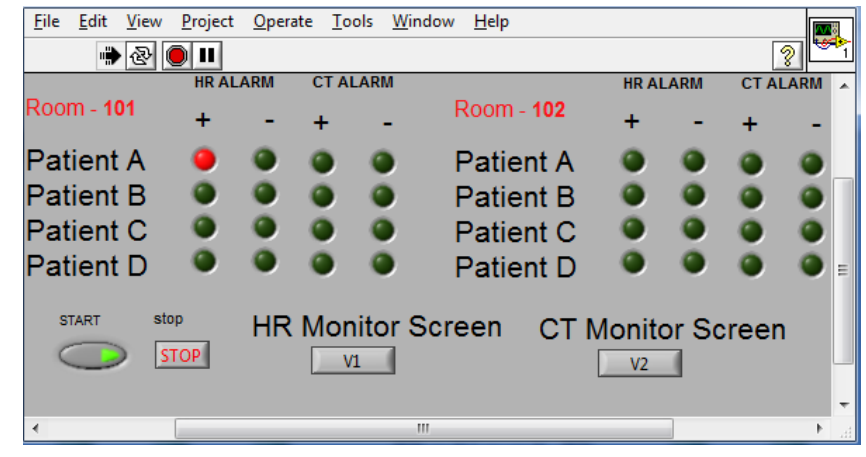
Figure 10. Main screen of the NSI showing the monitoring of two rooms and four